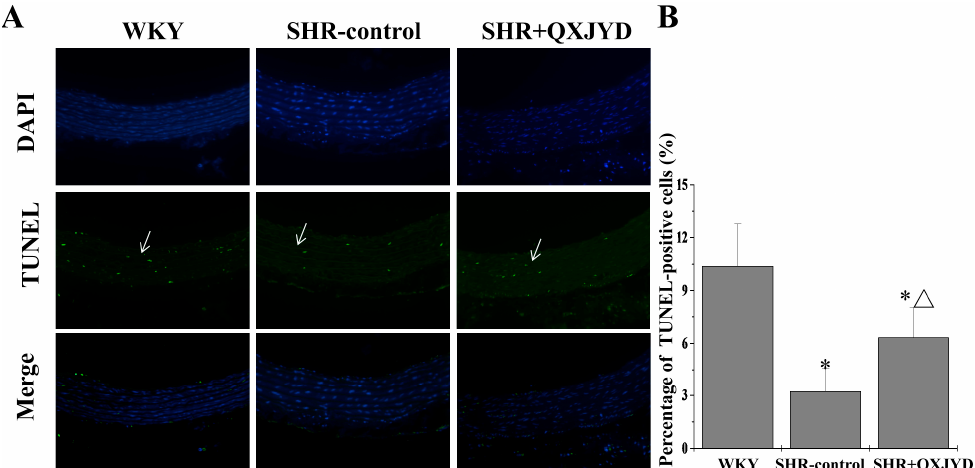
Figure 4. Effect of QXJYD treatment on apoptosis of VSMCs. ( A ) Thoracic aorta in each group ( n = 10) was processed for Terminal deoxynucleotidyl transferase dUTP nick end labeling (TUNEL) analysis. Nuclei of all cells were observed through 4,6-diamino-2-phenylindole hydrochloride (DAPI) staining, while apoptotic cells were visualized by green fluorescence. Images were representatives taken by confocal fluorescence microscope at a magnification of 20×; ( B ) Apoptotic rate was shown as the percentage of TUNEL-positive cells. All values were represented as mean ± SD; * p < 0.05 compared to WKY group; Δ p < 0.05 compared to SHR-control group.